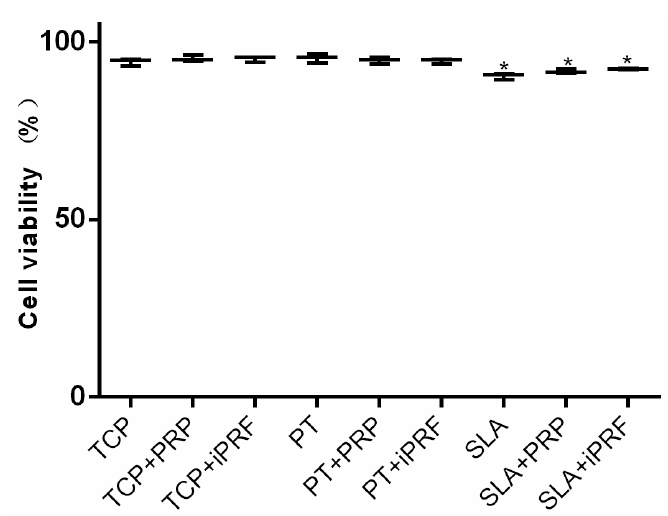
Figure 1. The percentage of human gingival fibroblasts quantified with a Live/Dead assay at 24 h on tissue culture plastic (TCP), Pickled titanium (PT) and Sand-blasted with Large grit particles followed by Acid-etching (SLA) with platelet rich plasma (PRP) or injectable platelet-rich fibrin (i-PRF) (* denotes difference between control TCP and experimental group, p < 0.05).